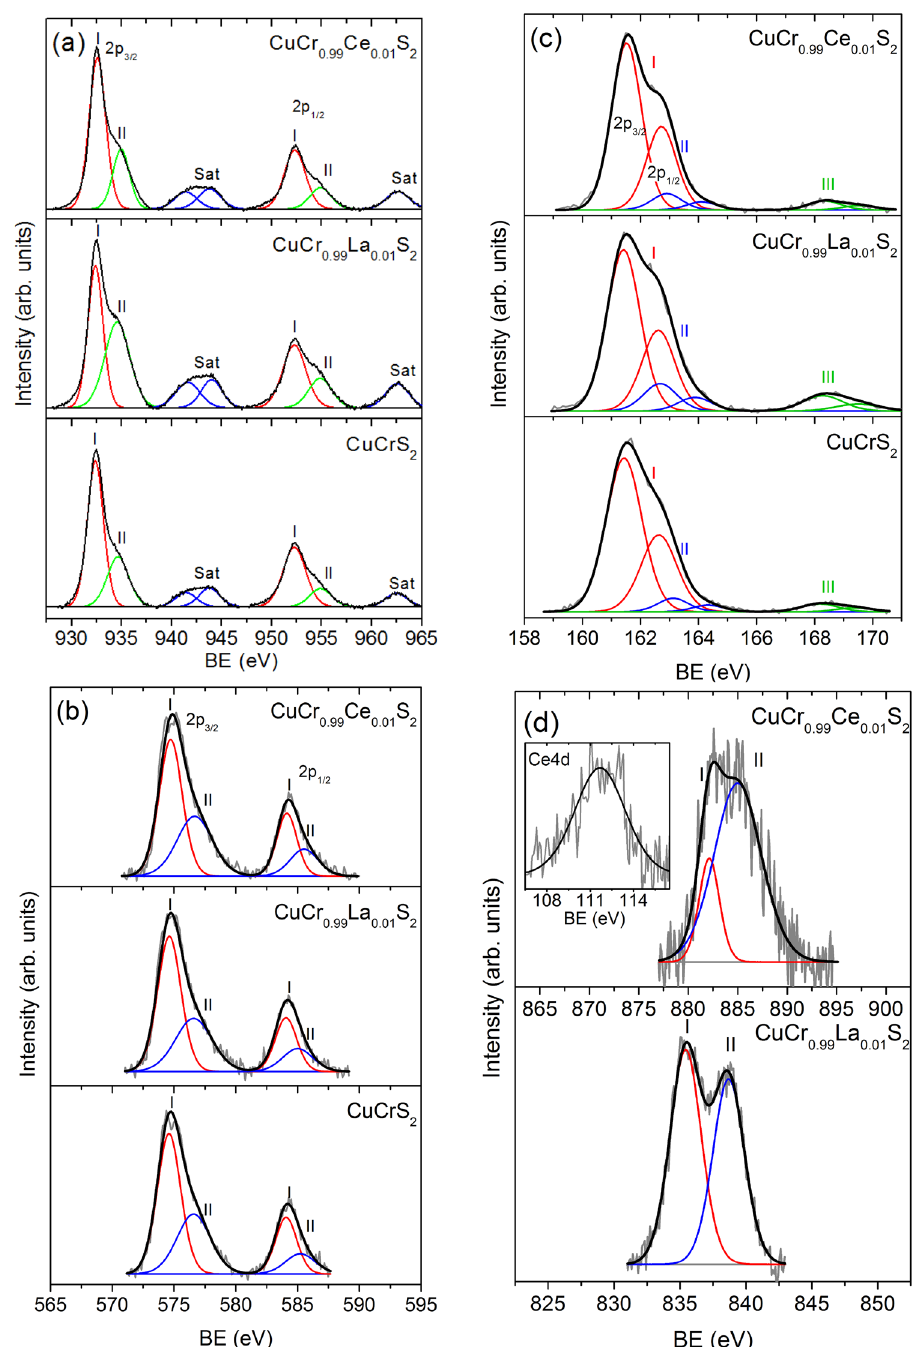
Figure 1. XPS lines of CuCrS 2 -matrix and lanthanide-doped solid solutions CuCr 0.99 Ln 0.01 S 2 (Ln = La, Ce): ( a ) Cu(2